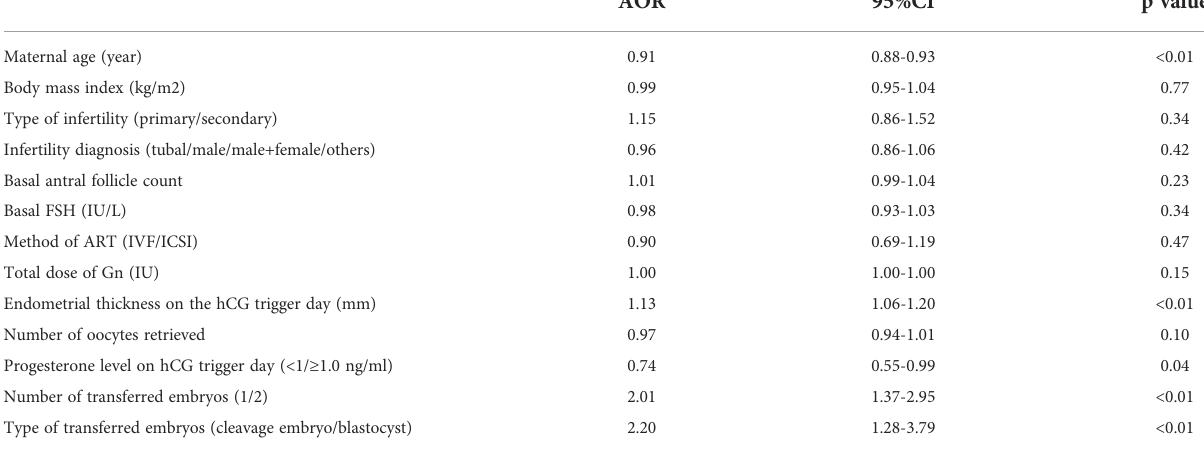
TABLE 4 Binary logistic regression analysis to account for confounding variables of live birth